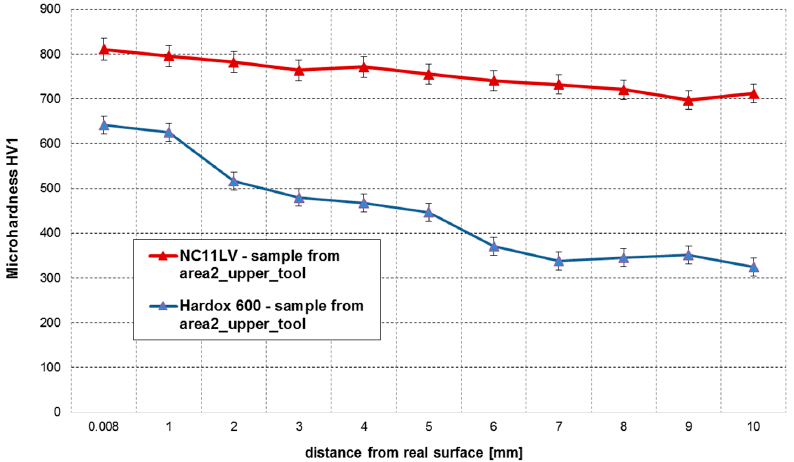
Figure 19. Hardness measurements at a distance from the working surface for area 2 (NC11LV and Hardox 600